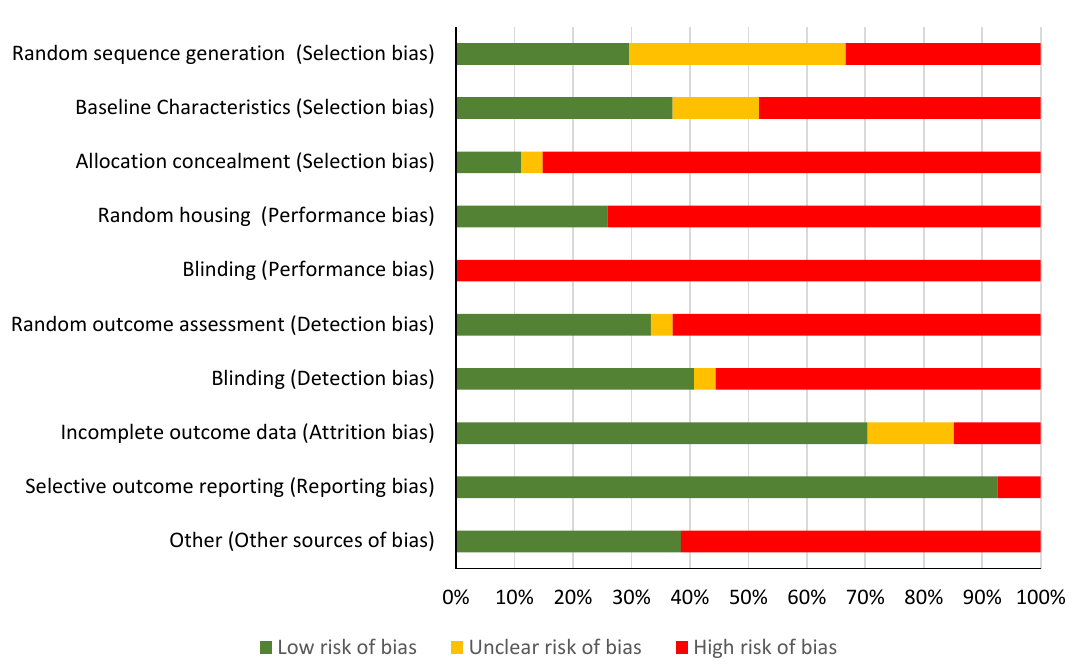
Figure 2. Percentage of studies that achieved either a low, unclear or high risk of bias for each domain using the SYstematic Review Centre for Laboratory animal Experimentation (SYRCLE) risk of bias tool. Although randomisation was mentioned in several articles, lack of reporting of the method used resulted in an unclear risk of bias for most items. Blinding was impossible to achieve due to the inherent nature of the study design.